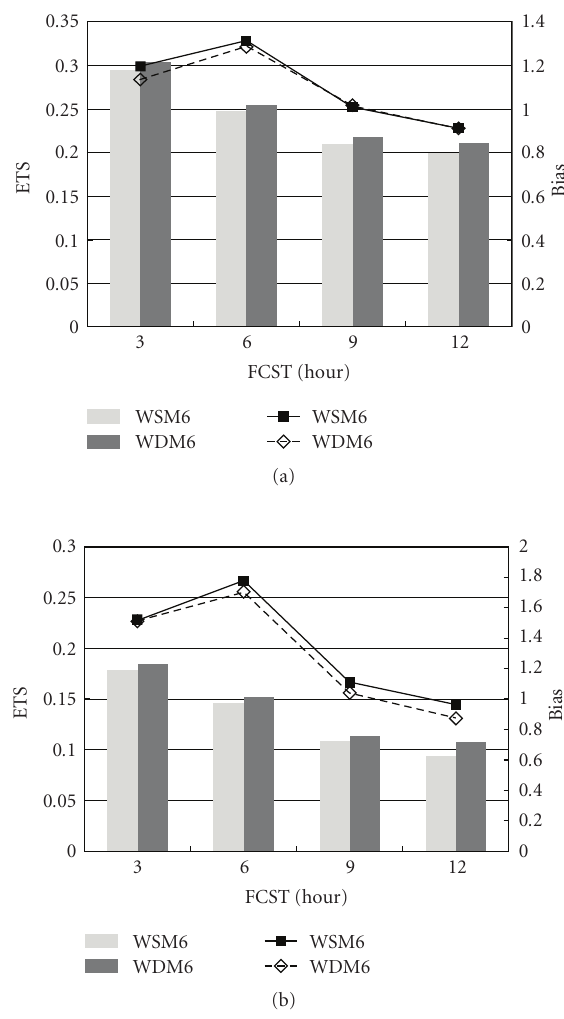
Figure 6: The time series of the equitable threat score (ETS; bars) and bias score (Bias; lines) for 3 hours accumulated precipitation over South Korea during the 12 hours forecast period, for (a) light precipitation (1mm/3 hours) and (b) heavy precipitaion (10mm/3 hours) categories. The total number of samples is 976, which consists of 8 times a day for June-July-August 2008. The number of observation used is about 600, which is about 13km apart over South Korea. The horizontal grid spacing is 5km covering the Korean peninsula, which is nested by the 15 km